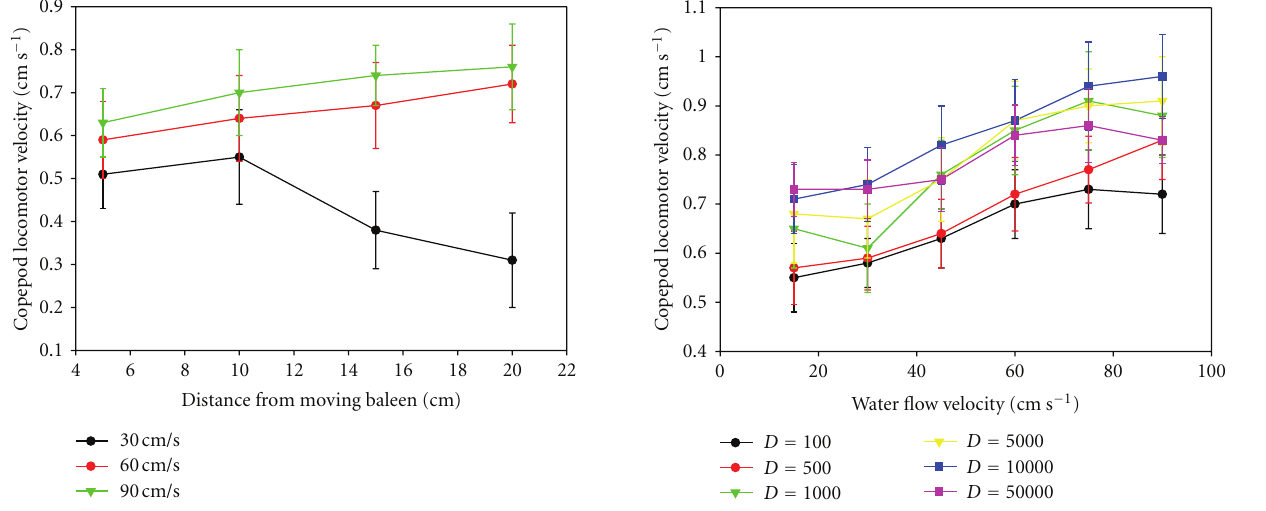
Figure 8: Influence of copepod ( Calanus ) density on locomotor velocity (mean, N = 35, error bars = 1SD) in flow tank, measured at distance = 10 cm from closest baleen, in light at 20 degrees C. Density range = 100 to 50,000 copepods m − 3